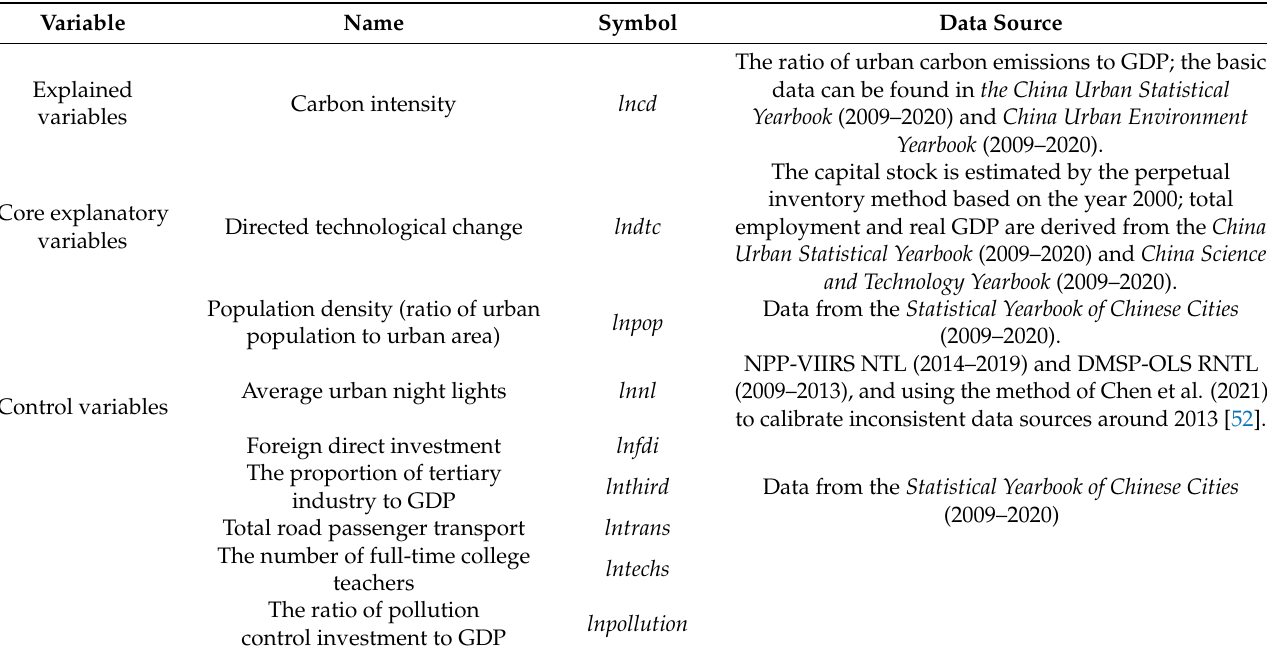
Table 1. Data description and